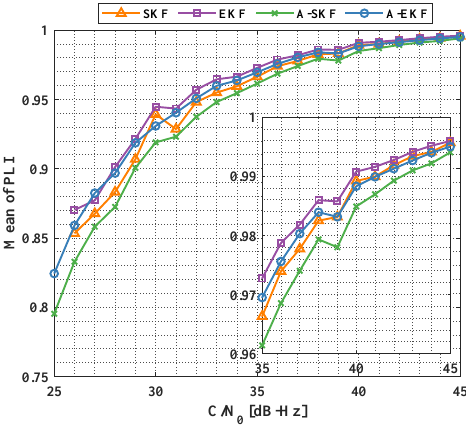
Figure 3. Means of the